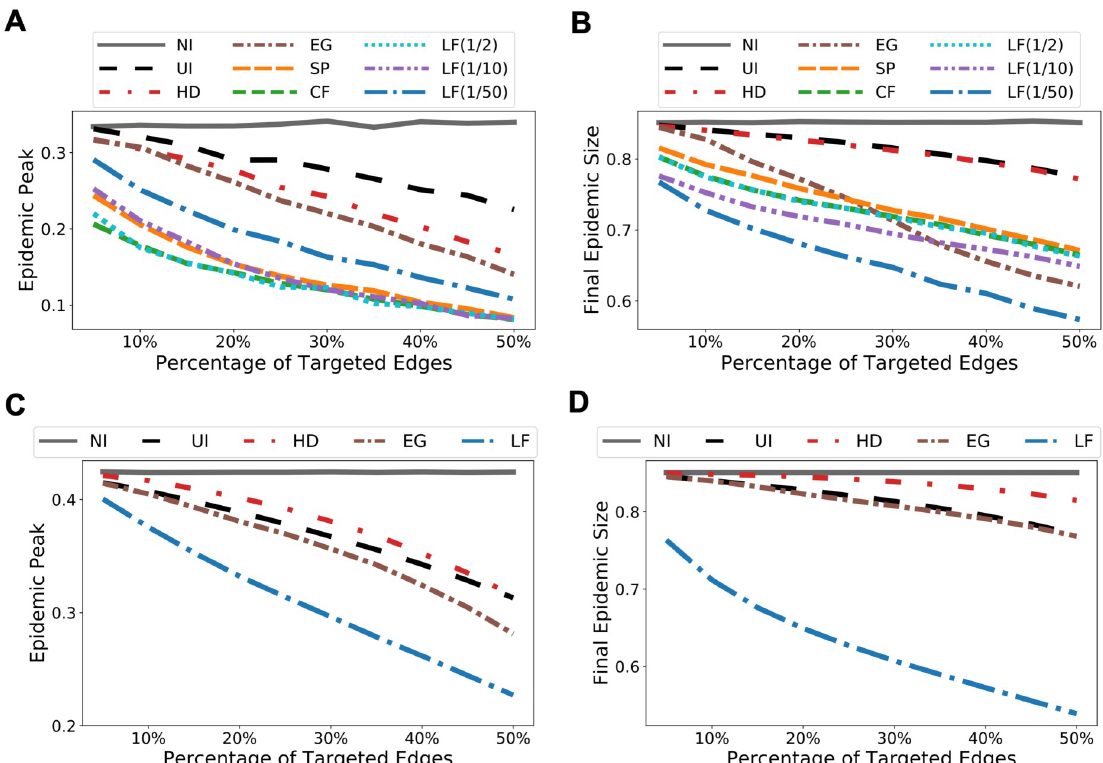
Fig 8. Simulation results for both sub-sampled and full Portland networks. For the full Portland network we used λ = 1/1000 for scalability. (A) Predicted epidemic peaks, sub-sampled network. (B) Predicted epidemic sizes, sub-sampled network. (C) Predicted epidemic peaks, full network. (D) Predicted epidemic sizes, full